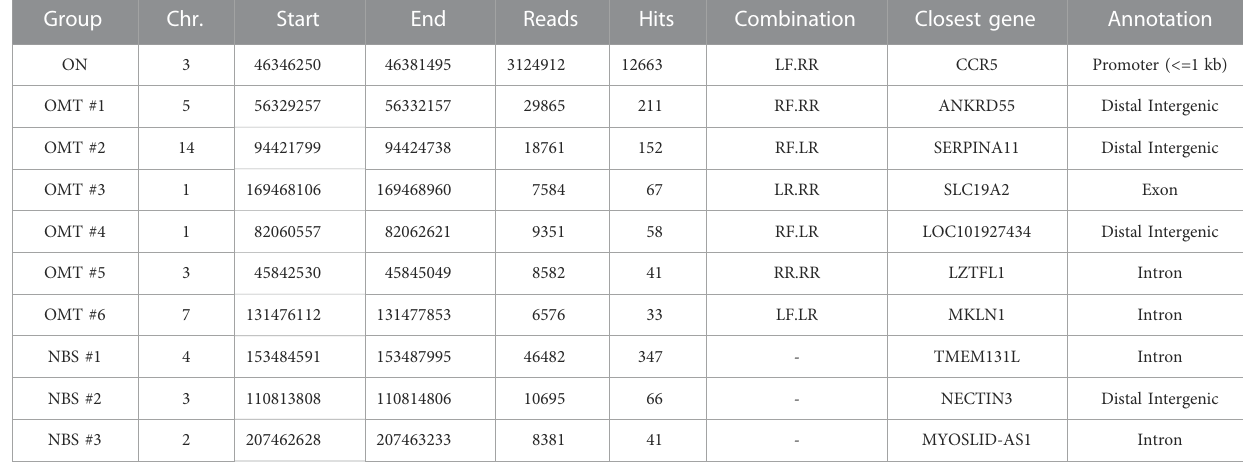
TABLE 1 CAST-Seq results for CCR5 -targeting TALEN. Listed are OMTs with > 20 hits and NBSs with > 40 hits. TALEN combinations: LF, left TALEN arm in forward orientation; LR, left TALEN arm in reverse orientation; RF, right TALEN arm in forward orientation; RR, right TALEN in reverse orientation. Group